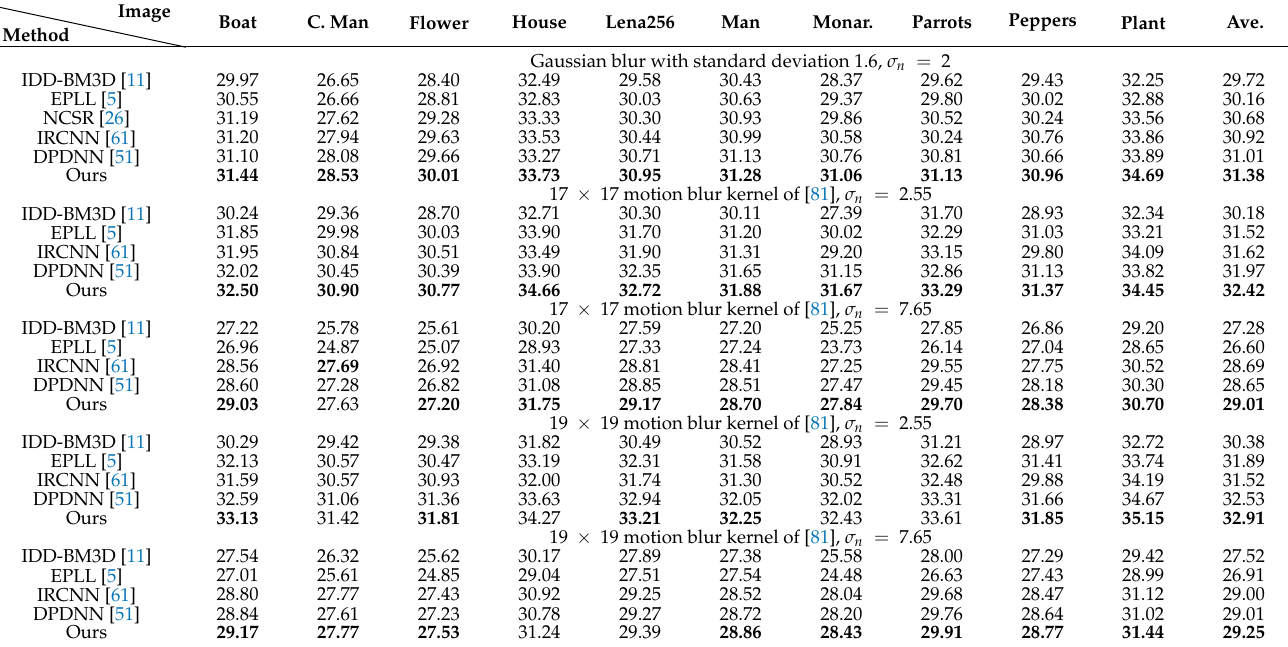
Table 5. The PSNR values of the deblurred 10 images in Figure 3 by the test methods. Image Method